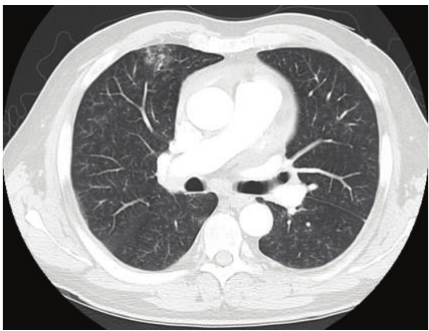
Figure 1: CTPA indicating subtle bilateral and diffuse bronchiolar densitieswithtree-in-budappearancebutnoevidenceofpulmonary embolism.